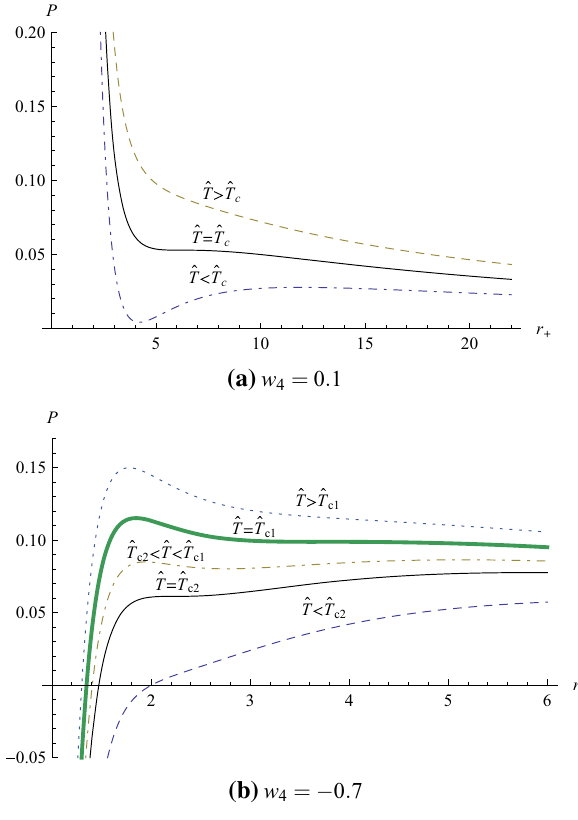
Fig. 1 The P − r + diagrams of six-dimensional AdS black holes for w = − 1 and w = 1. a The upper dashed line corresponds to the idea 2 3 gas phase behavior for ˆ T > ˆ T c . The critical temperature case ˆ T = ˆ T c is denoted by the solid line . The line below is with temperatures smaller than the critical temperature. We have ˆ T c = 0 . 9788 in a . In b , we have now two critical points at positive pressure. The upper one has higher radius, temperature, and mass. We have ˆ T c 1 = 1 . 27718 and ˆ T = 1 . 1718 in c 2